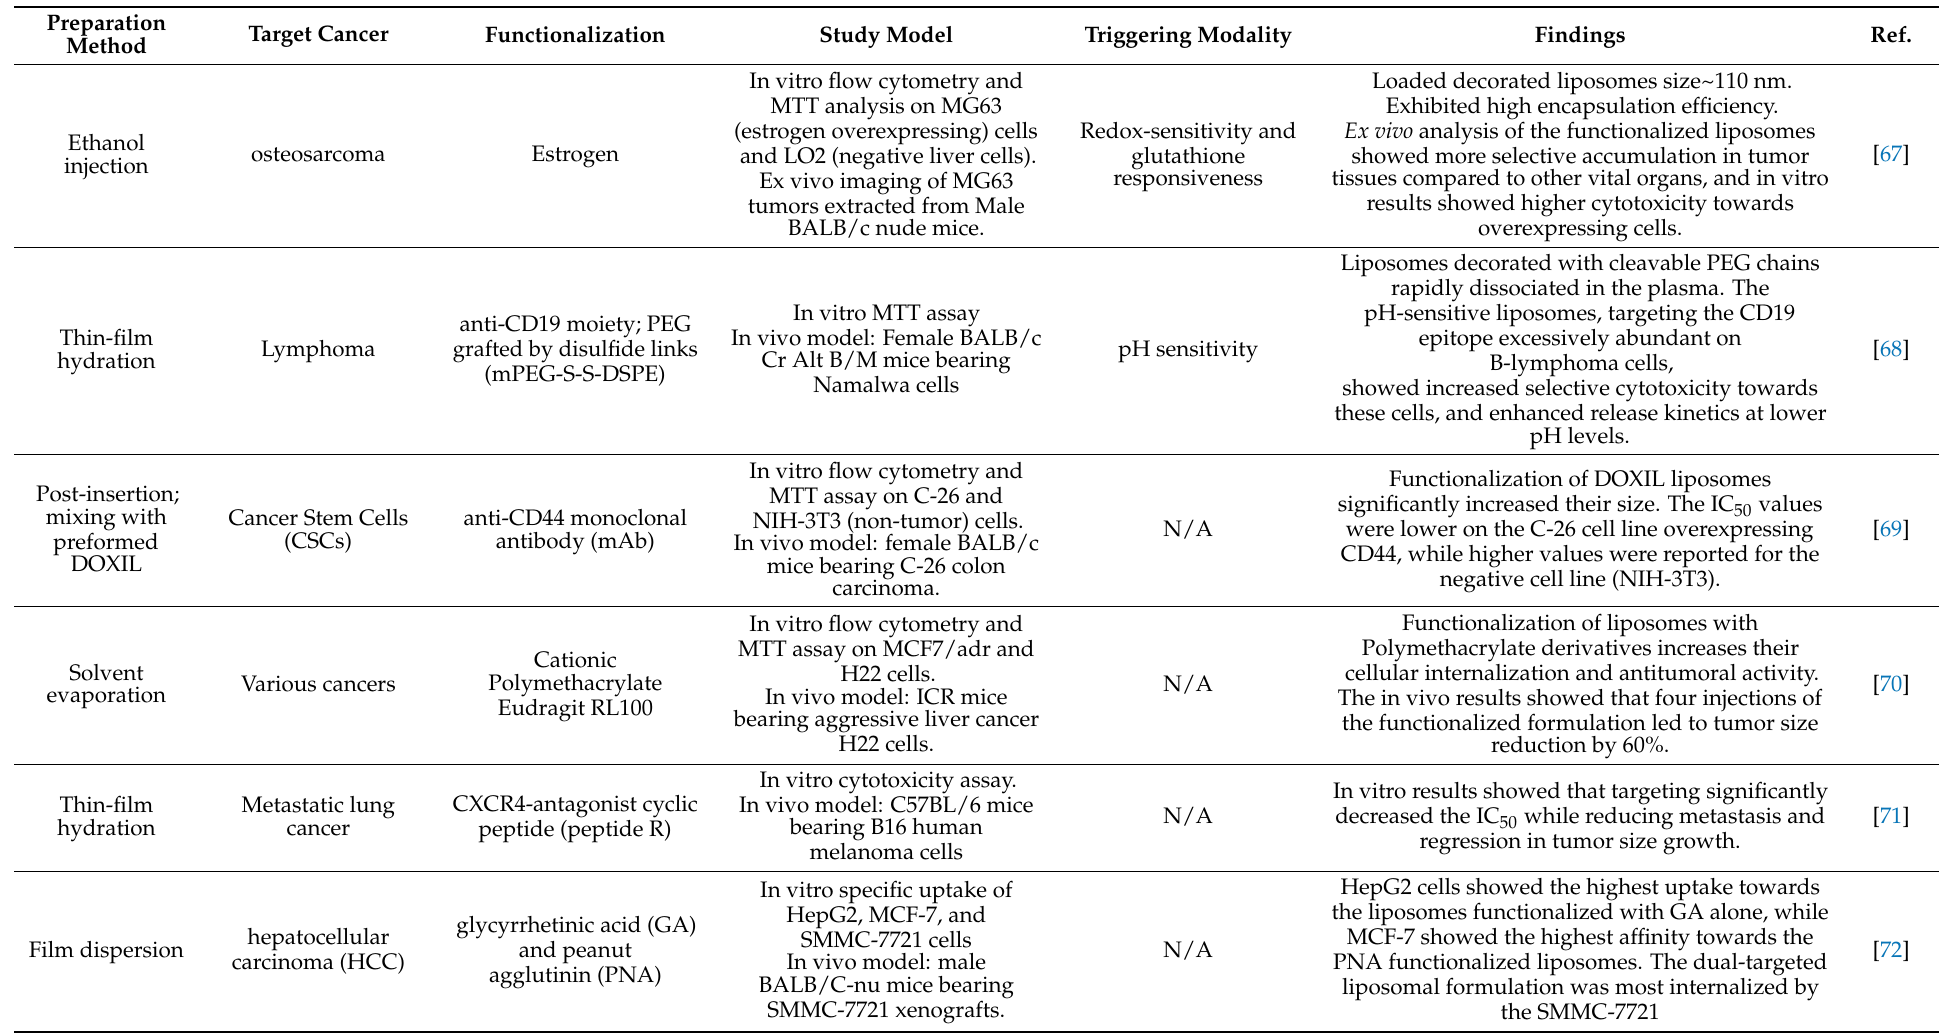
Table 2. Different liposomal-based DDS encapsulating DOX via the (NH 4 ) 2 SO 4 transmembrane gradient